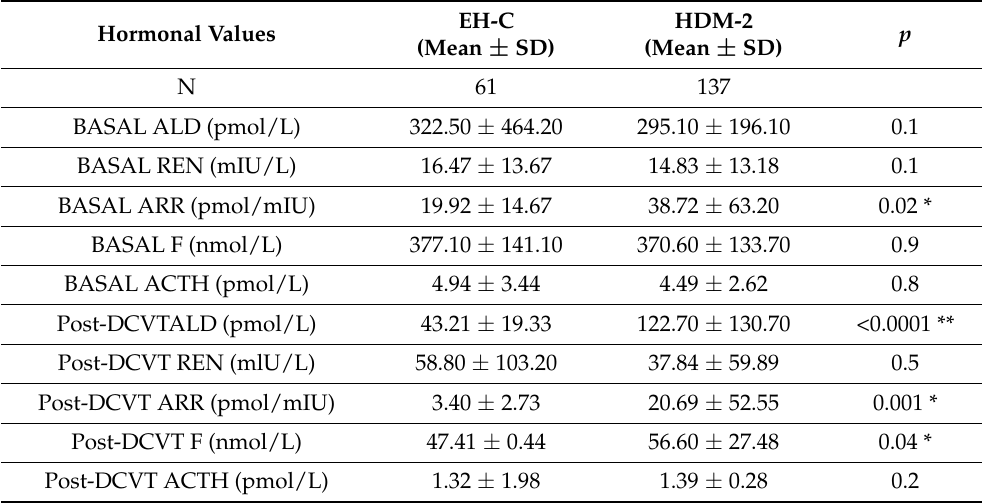
Table 2. Hormonal levels in basal and post-DCVT among all hypertensive patients with DM-2 (HDM-2) and patients with essential hypertension (EH-C), who served as